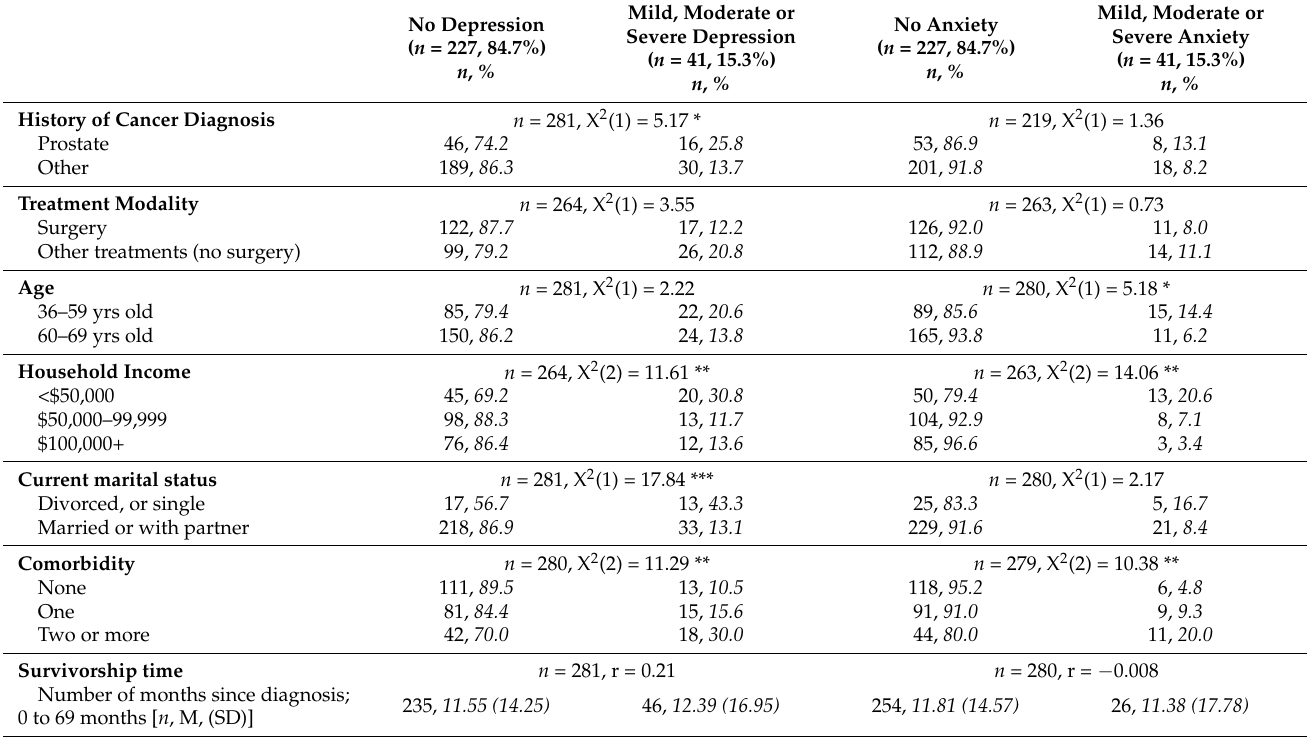
Table 1. Descriptive, logistic and correlational analyses predicting screening positive for depression or anxiety by type of history of cancer diagnosis, treatment modality, age, household income, current marital status, comorbidity and survivorship time among adult men residing in Atlantic Canada, aged 36+, between 2009 and 2015 ( n = 281 screening positive for depression; n = 280 screening positive for anxiety).